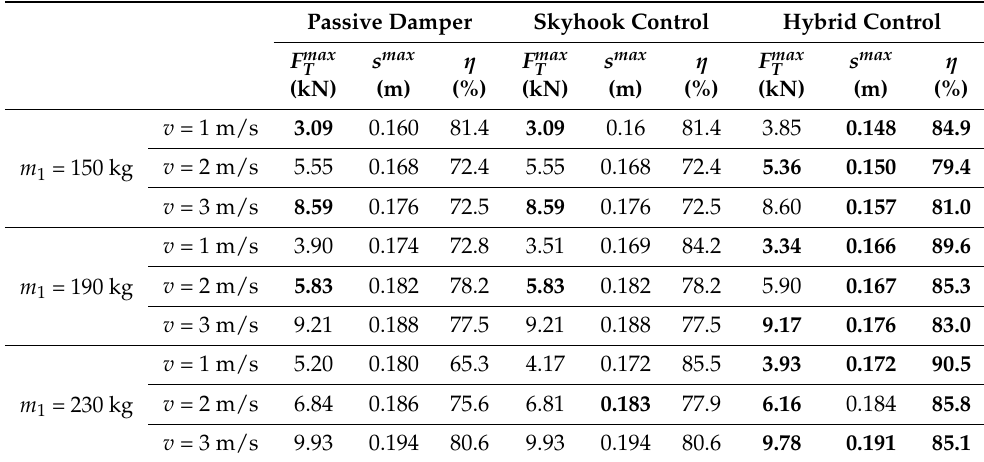
Figure 8. ( a ) Voltage applied to MR core, ( b ) efficiency curve. The drop test results of the landing gear using the passive damper, skyhook controller, and hybrid controller in the case of m 1 = 190 kg, v = 1 m/s. Table 1. Damper performance using passive damping, skyhook controller, and hybrid controller in differing landing cases. The best result for each criterion is marked in